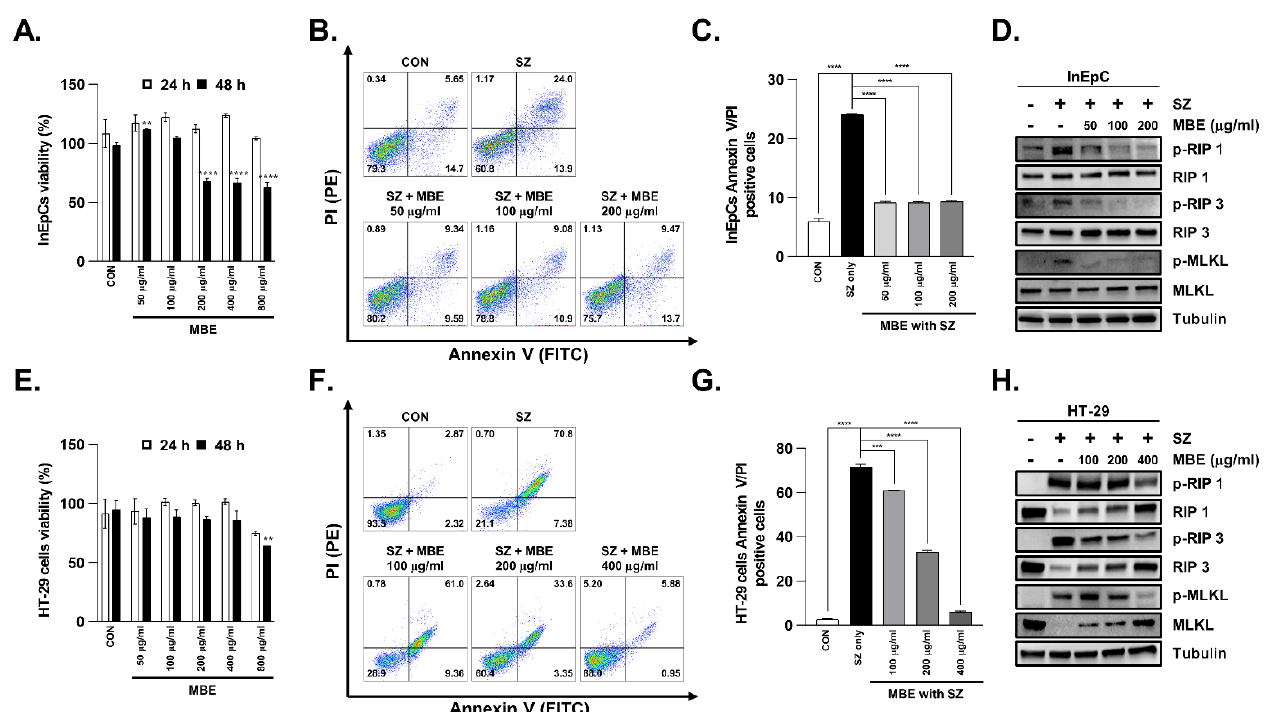
Figure 3. MBE efficiently blocks SZ-induced necroptosis in both InEpCs and HT29 cells. ( A ) Effects of MBE on the viability of InEpC cells treated with the indicated extract concentration for 24 h and 48 h. ( B ) InEpC cells were pretreated with the indicated concentrations of MBE for 30 min before treatment with SZ (Smac mimetic (20 µM) and z − VAD (20 µM)) for 24 h. annexin V/PI was analyzed using flow cytometry. ( C ) The values represent the sum of the percentage of cells in A (PI+ annexin V+; necroptosis). ( D ) Levels of pRIP1, RIP1, pRIP3, RIP3, pMLKL, and MLKL were analyzed using immunoblotting. Tubulin was used as a loading control. ( E ) HT29 cells were treated with the indicated concentrations of MBE for 24 h and 48 h. ( F ) HT29 cells were pretreated with the indicated concentrations of MBE for 30 min before treatment with SZ (Smac mimetic (100 nM) and z − VAD (20 µM)) for 12 h. The expression of annexin V in HT29 cells was induced by SZ and analyzed using flow cytometry. ( G ) The values represent the sum of the percentage of cells in E (PI+ annexin V+; necroptosis). ( H ) Levels of pRIP1, RIP1, pRIP3, RIP3, pMLKL, and MLKL were analyzed using western blotting. Tubulin was used as a loading control. ** p < 0.01, *** p < 0.001, and **** p < 0.0001 (data were analyzed using an ANOVA).